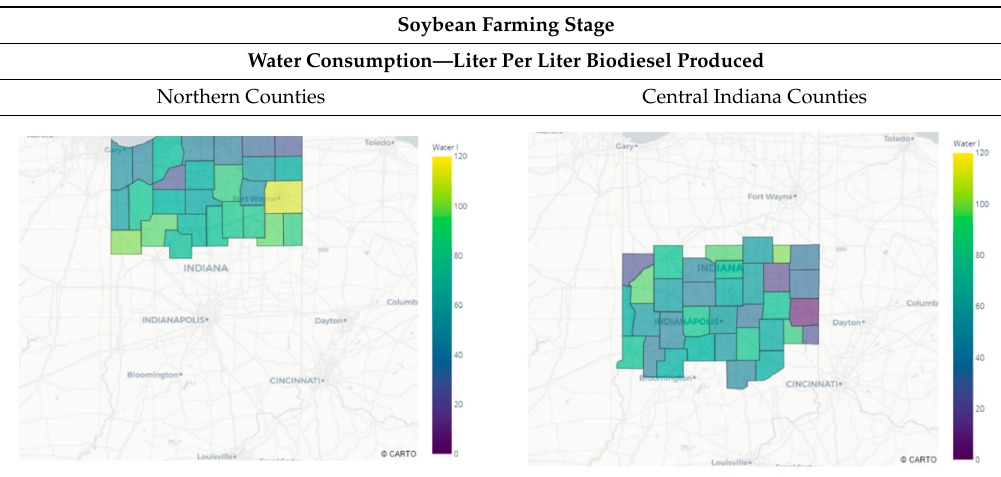
Table 3. Environmental impacts per liter of biodiesel produced. Impacts are distributed across the di ff erent life cycle